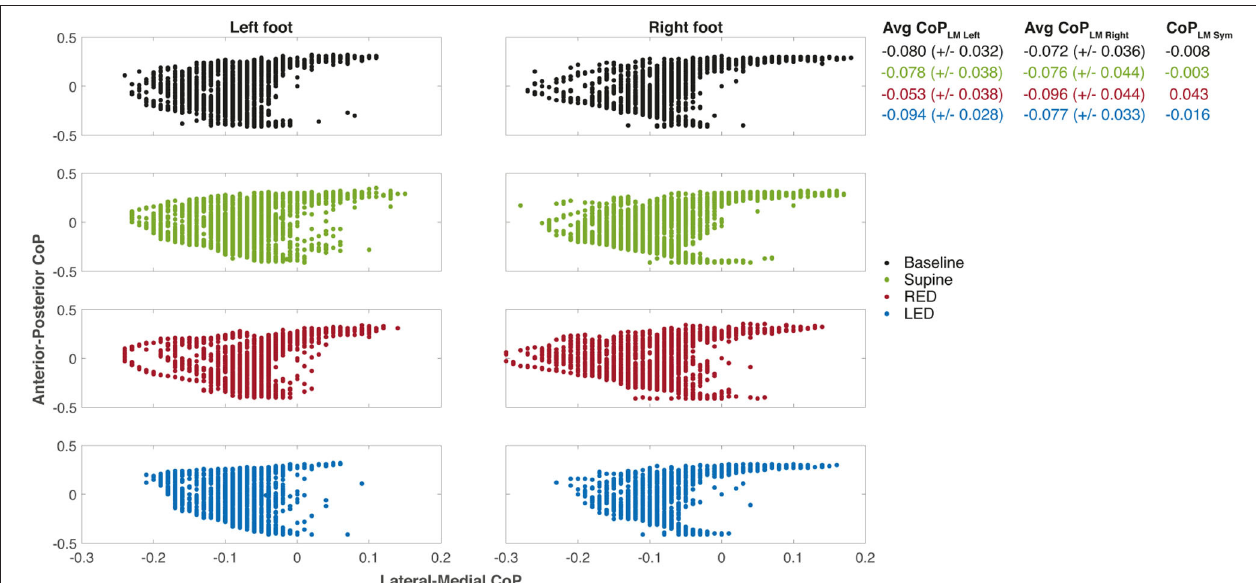
FIGURE 6 | The CoP coordinates of each leg during the first WS for each resting position of the same subject. The examples depict the same measurements of subject #25 as shown in Figure 5 . The positive x-axis values are medial, and the positive y-axis values are anterior CoP displacements. The CoP output of the sensory insoles on both axes ranges from − 0.5 to 0.5 and is related to the corresponding insole length or width, respectively. Some values appeared more than once which is not illustrated in the figure. Averaged CoP LM values are presented next to each plot for left and right foot as well as well as the CoP LMSym all together with their standard